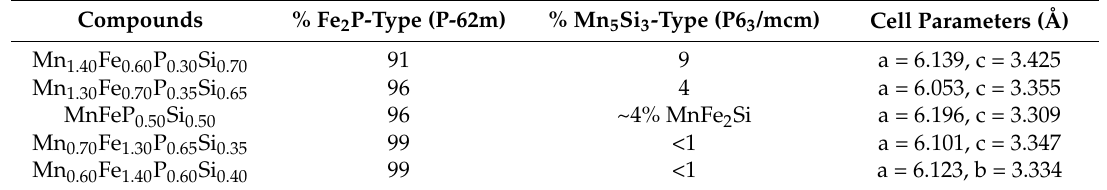
Table 2. Extra phases identified in Mn 2 − x Fe x P 1 − y Si y synthesized by melting Fe-P and Mn-Si precursors. Compounds